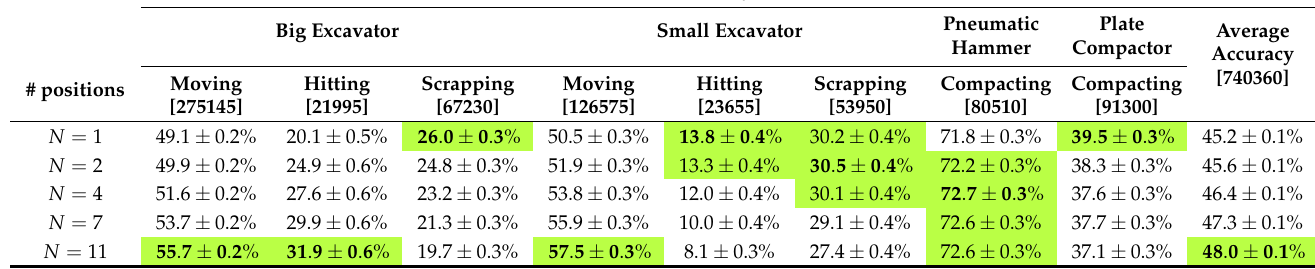
Table 3. Results for the machine + activity identification mode by varying the number of positions used in the GMM training with the best result for each class and the best overall accuracy in bold font. Confidence intervals are shown for a 95% confidence. Green cells show values within the confidence interval for the best performance value (i.e., statis- tically non-significant differences). The values shown between brackets denote the number of frames that belong to the corresponding